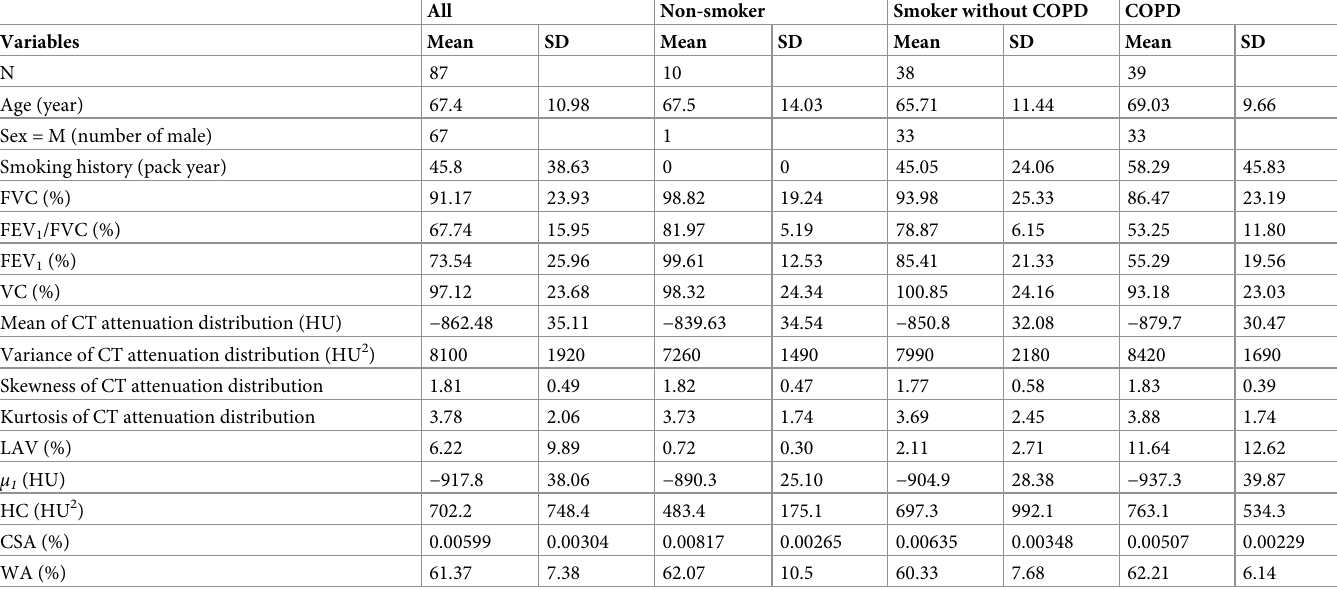
Table 1. Summary of patient characteristics, PFT results, COPD quantification values.